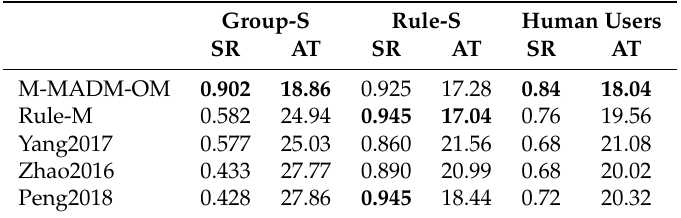
Table 2. Cross-model evaluation on Success Rate (SR) and Average Turns (AT). Group-S Rule-S Human Users SR AT SR AT SR AT M-MADM-OM